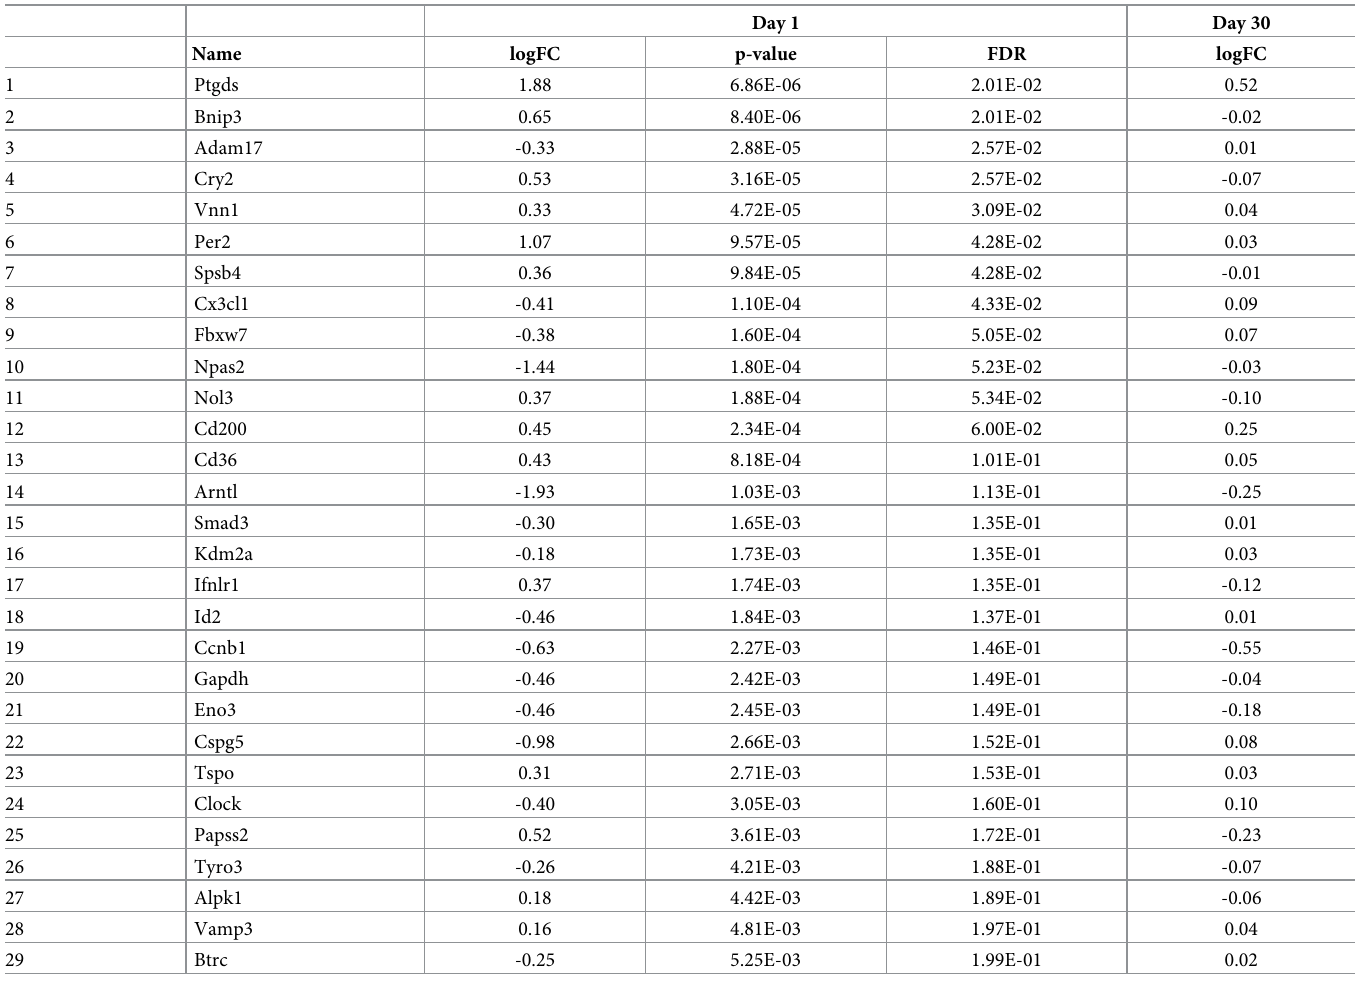
Table 3. The list of DEG in selected pathways reflecting short-term effects of repeated acute ISO exposures.